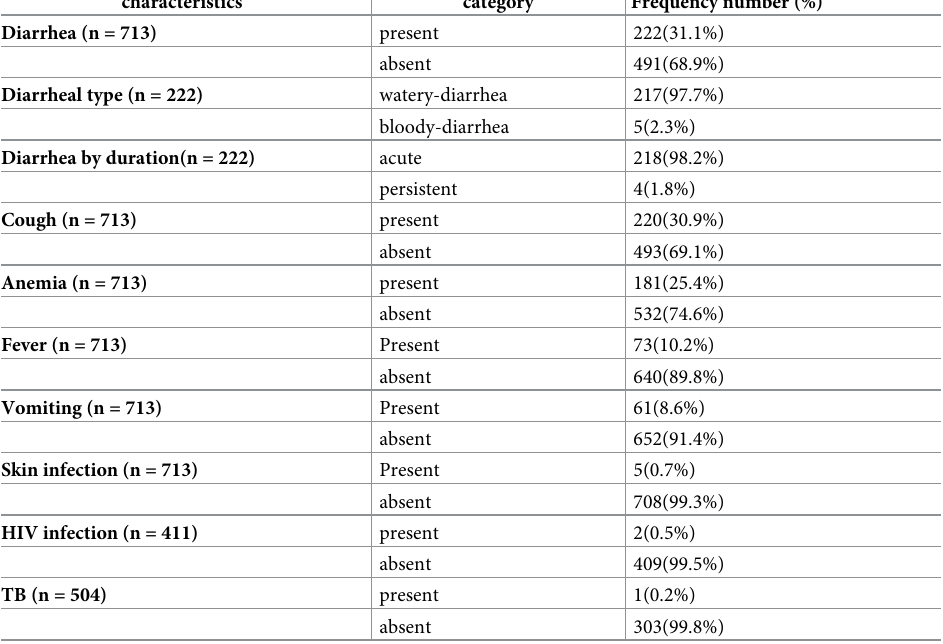
Table 2. Medical co-morbidity characteristics of children with SAM on admission under OTP in Dire Dawa, Ethi- opia; from January, 2013 to December, 2016. characteristics